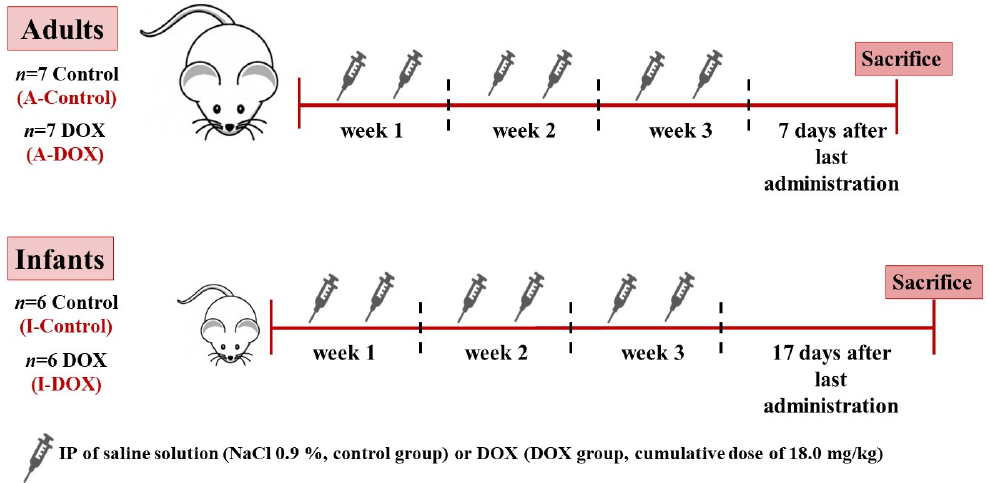
Figure 1. Schematic representation of the methodology used. Over three weeks, mice were biweekly injected intraperitoneally (IP) with saline solution (control groups) or DOX (total cumulative dose: 18.0 mg/kg, DOX groups, which corresponds in humans to 100.6 mg/m 2 for infants and 108.9 mg/m 2 for adults).